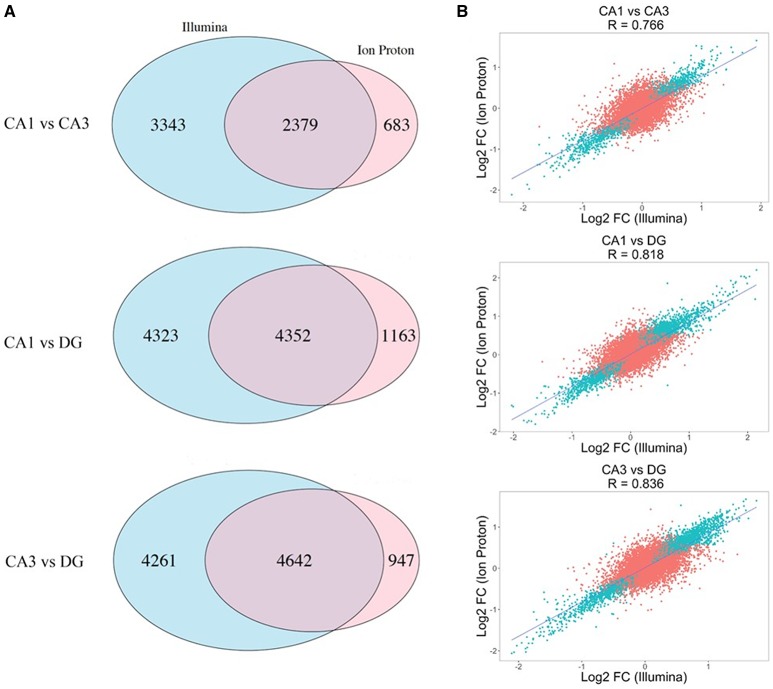
Differential expression across the Illumina and Ion Proton platforms. (A) Proportional Venn diagrams showing the concordance for genes that were significant after p-value adjustment for the Illumina and Ion Proton in each pairwise comparison indicated (CA1 vs. CA3; CA1 vs. DG; CA3 vs. DG). For example, total number of significant genes for CA1 vs. CA3 were 5722 and 3062 for Illumina and Ion Proton, respectively, with an overlap of 2379. (B) Scatterplot of the fold changes for all detected genes across both platforms. Blue points are the genes differentially expressed in Illumina and Ion Proton (adj-p < 0.05).